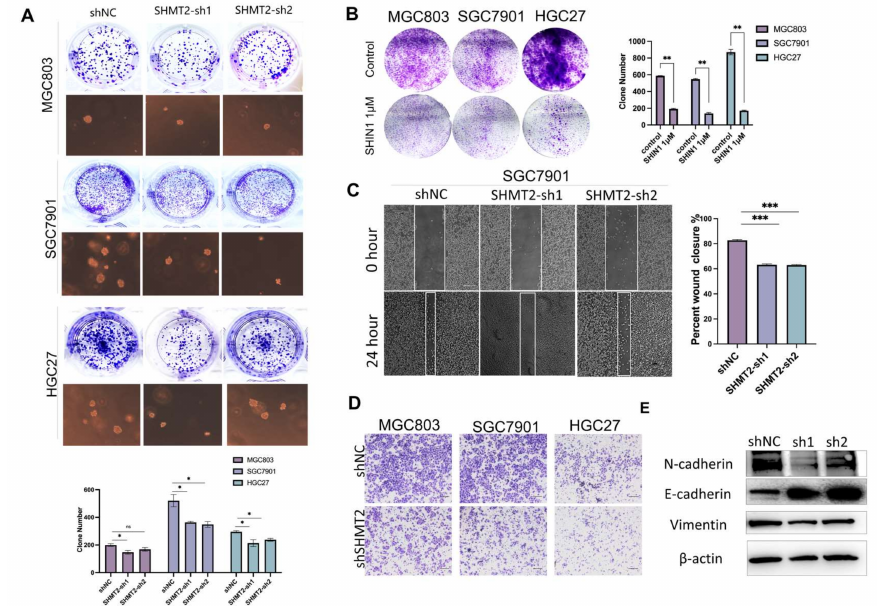
Figure 3. SHMT2 knockdown inhibited GC cell invasion and metastasis. ( A ) Representative im- ages of SHMT2 knockdown’s effect on cell colony formation (plate clones and soft agar clones) and quantitative analysis of colony formation. ( B ) Representative images and quantitative analysis of the effect of SHIN1 (1 µ M) on cell colony formation. ( C ) Transwell assay detected the effect of SHMT2 knockdown on the cell migration ability and the representative images. Scale bar, 100 µ